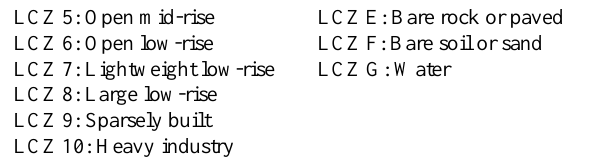
Table 1 . Description of Local Climate Zones as defined by (Cai et al., 2018).